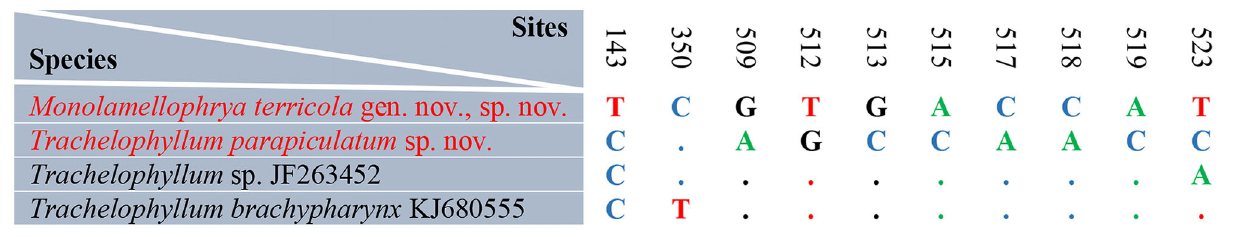
FIGURE 8 | Sequence comparison of the 18S rRNA gene showing the unmatched nucleotides among the new species Monolamellophrya terricola gen. nov., sp. nov., Trachelophyllum parapiculatum sp. nov., and the other two available trachelophyllid species.